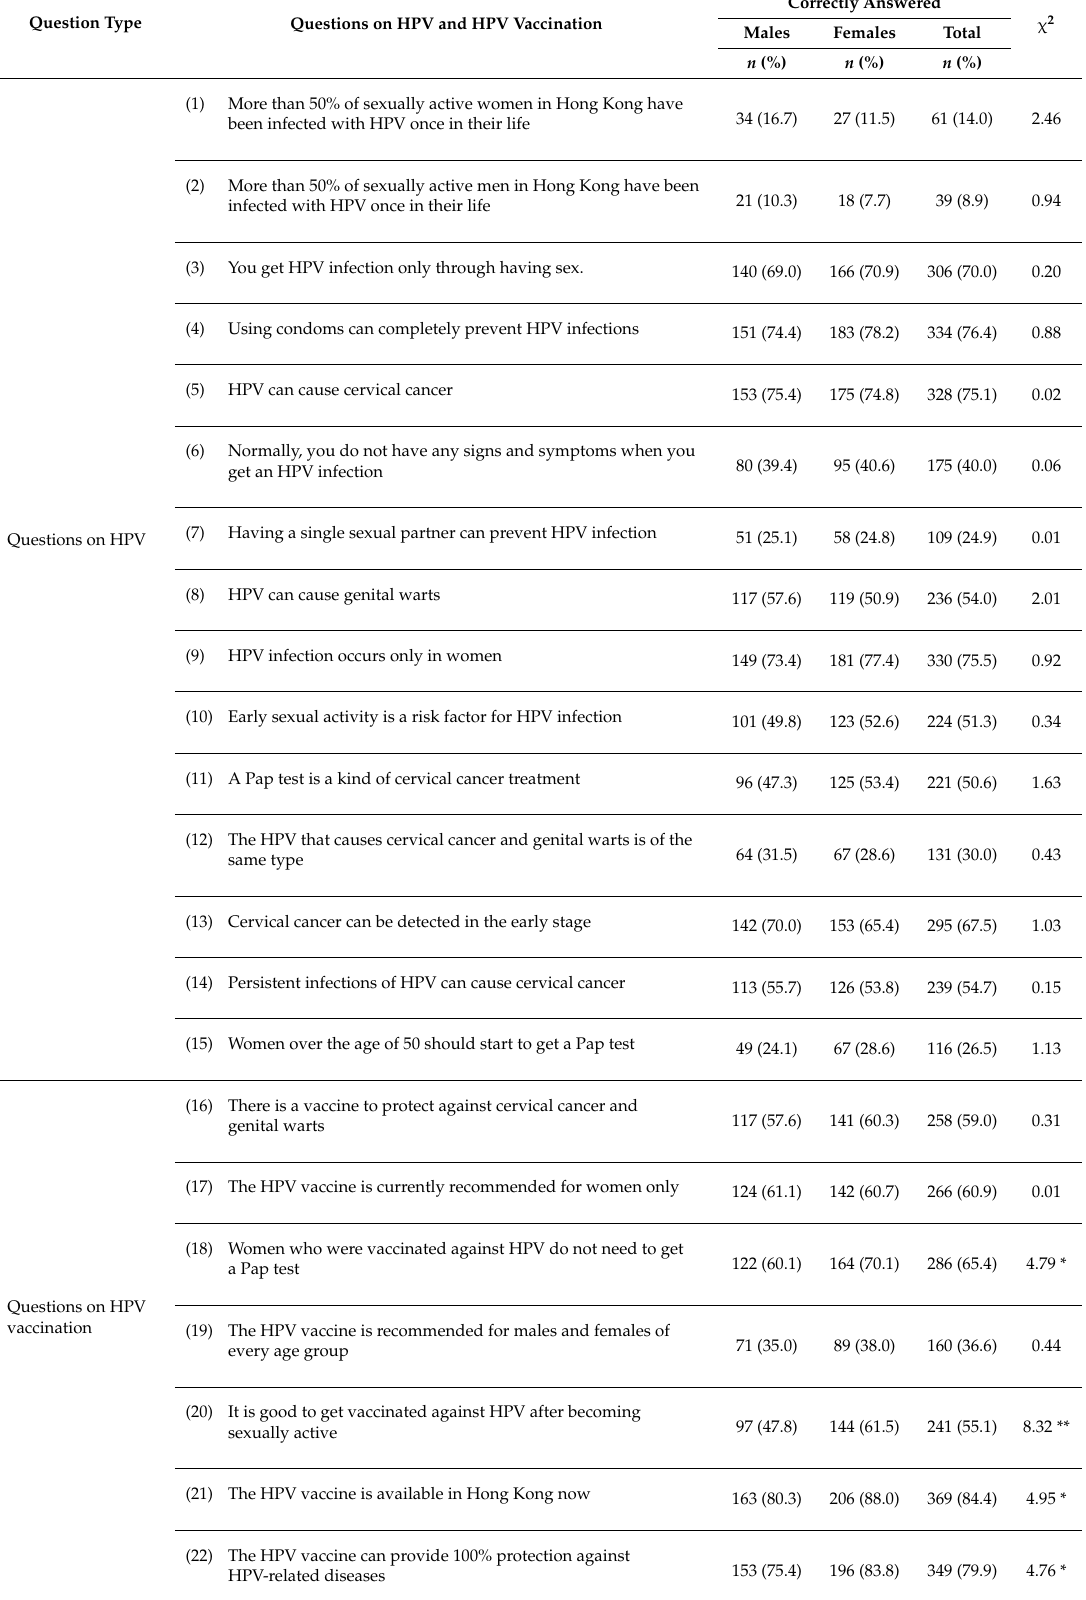
Table 5. Gender differences in knowledge of HPV